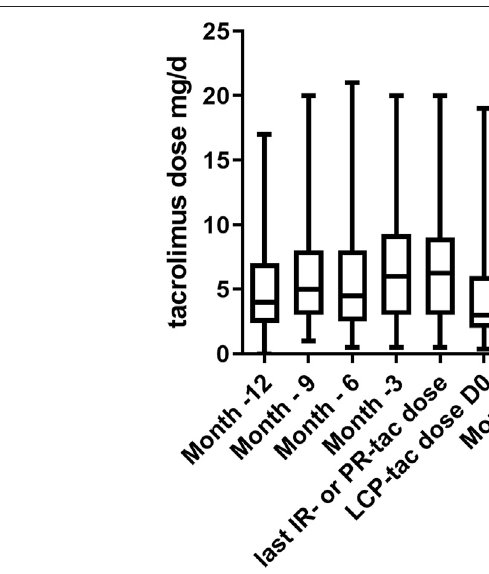
Frontiers in Pharmacology |